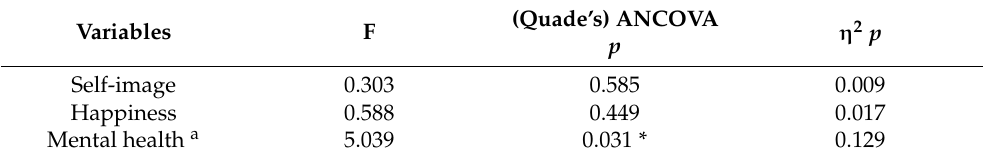
Table 3. The effects of the intervention on measured